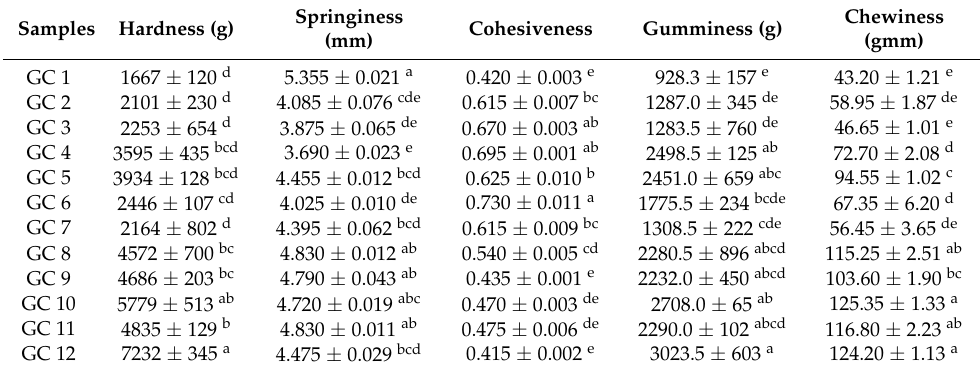
Table 5. Textural properties of different